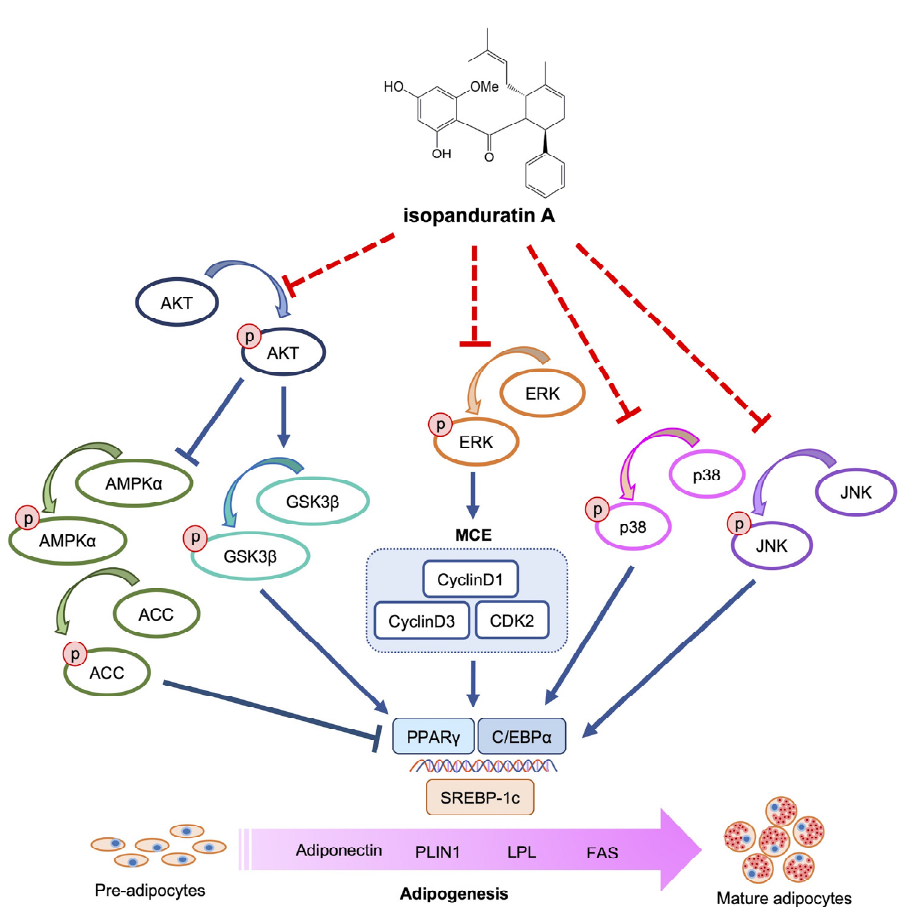
Figure 9. Proposed regulatory mechanisms of isopanduratin A on the suppression of adipogenesis. Isopanduratin A decreases adipocyte generation and cellular lipid accumulation by downregulating adipogenic effectors (FAS, PLIN1, LPL, and adiponectin) and adipogenic transcription factors (PPAR γ , C/EBP α , and SREBP-1c). The multi-target inhibitory properties of isopanduratin A are evidenced by its modulation on mitotic clonal expansion-regulating proteins (CyclinD1, CyclinD3, and CDK2) and AKT (AKT/GSK3 β and AKT/AMPK-ACC) and MAPK (JNK, ERK, and p38) signals.